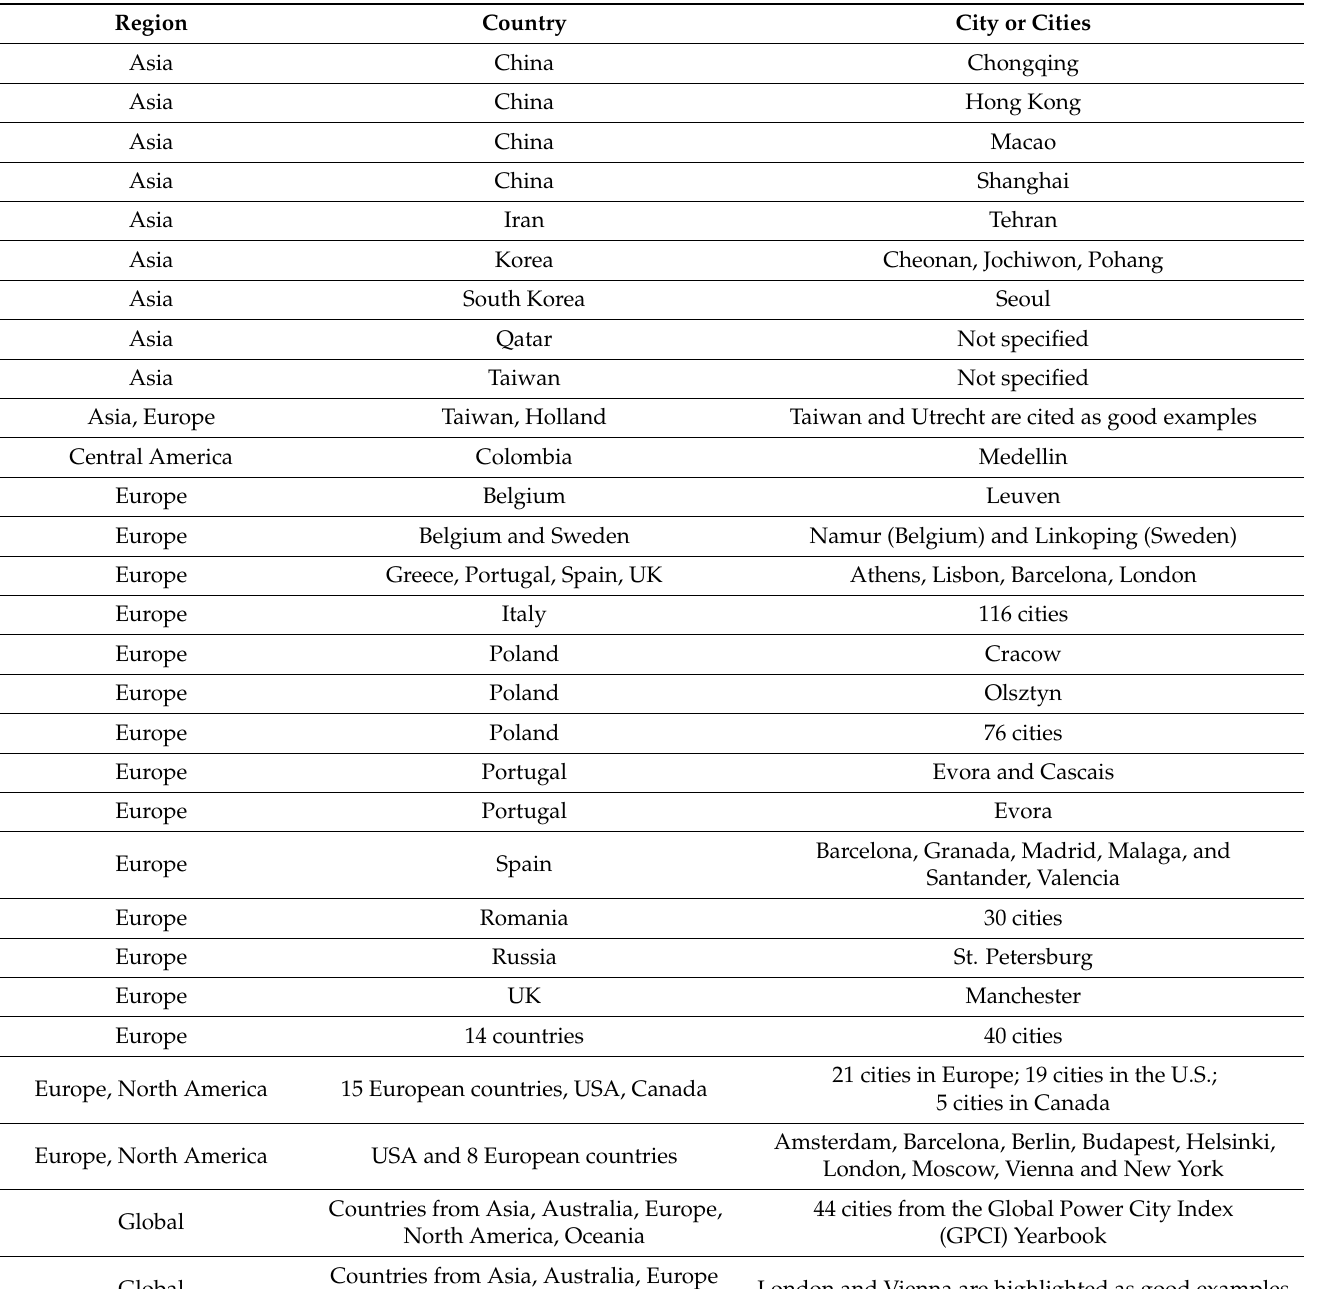
Table 1. Locations of the studies. Source: Authors’ own